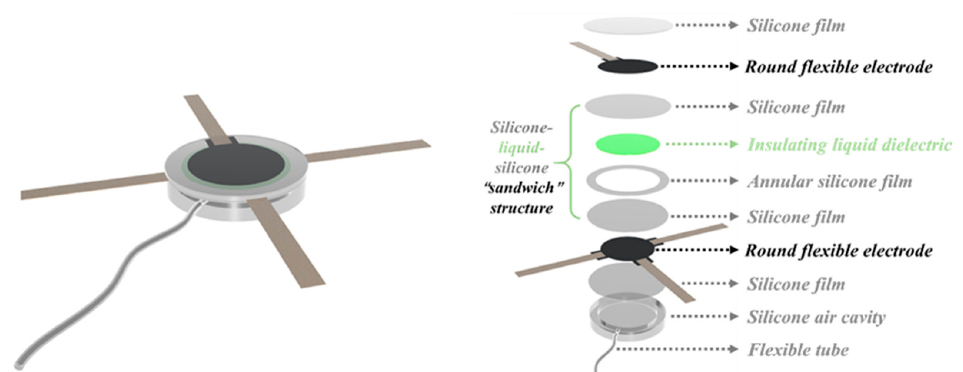
Figure 1. Exploded view of the